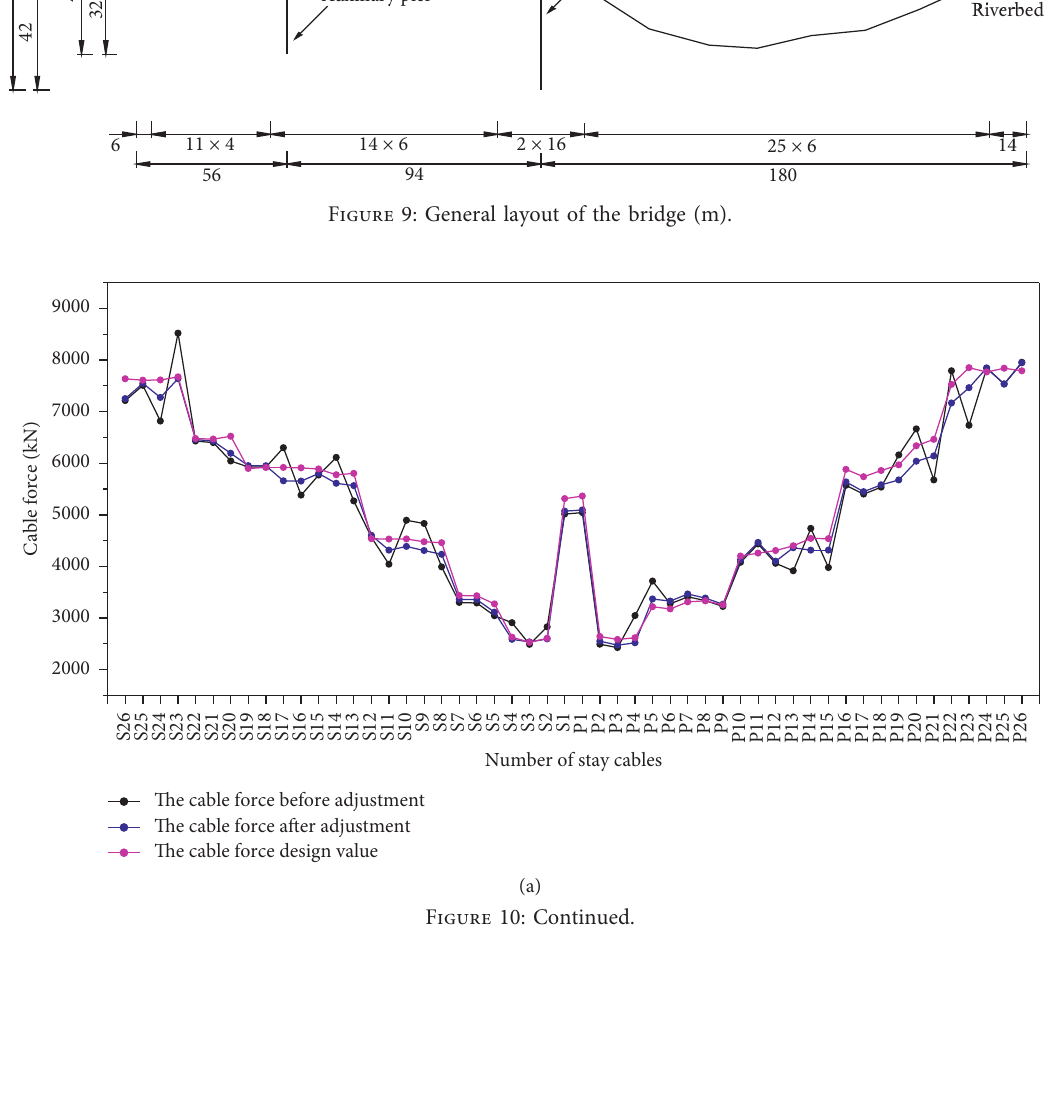
Figure 9: General layout of the bridge (m).